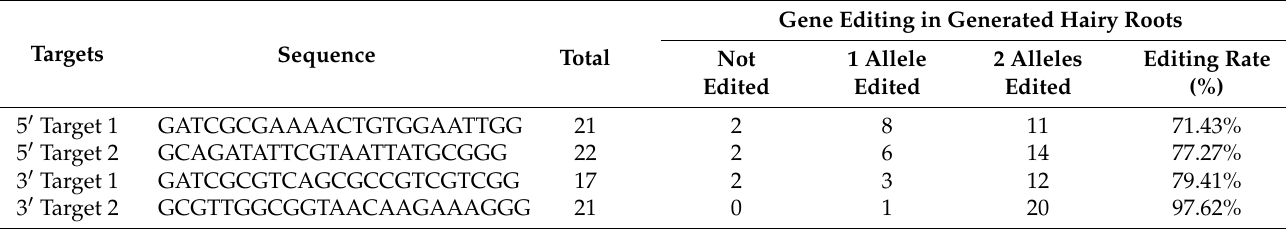
Table 1. Gene-editing efficiencies of different gRNAs targeting the GUS